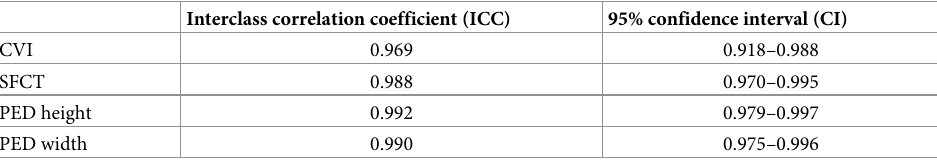
Table 2. Inter-rater reliability assessment of measured